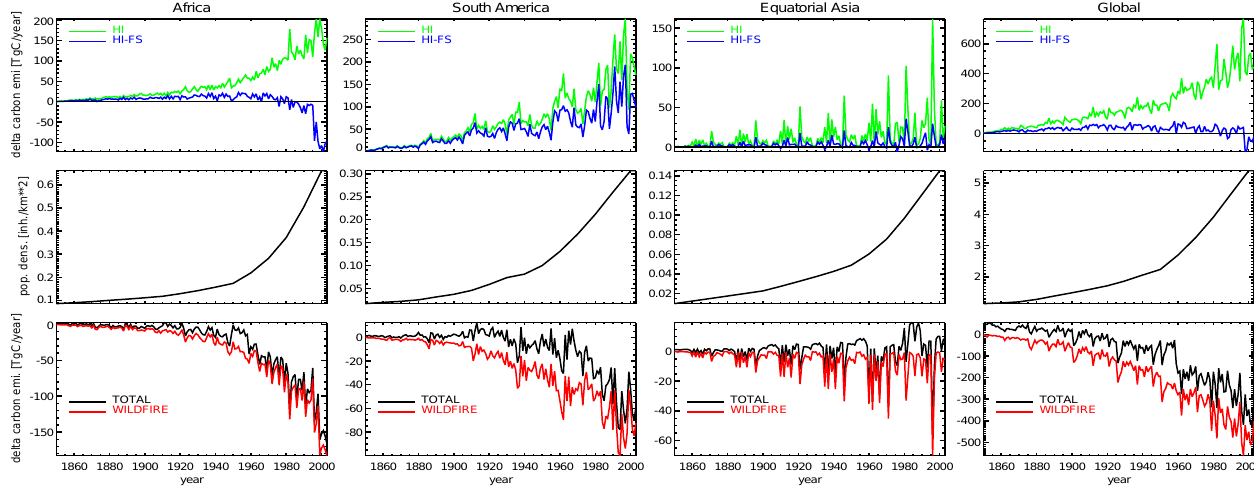
Fig. 8. Sensitivity to changes in population density and land use change and wood harvest for selected regions and globally. (A) Annual mean change in carbon emission from total fires (natural and deforestation) caused by changes in population density in the case of only human ignition is considered (green line, AB-HI – AB-HI-PI) and human ignition and fire suppression considered (blue line, AB-HI-FS – AB-HI-FS-PI) in [TgC/year]; (B) population density [inhabitants/km 2 ]; (C) change in total (wildfire and deforestation) fire carbon emissions (black) and wildfire fire carbon emissions (red) caused by land use change and wood harvest in [TgC/year] (AB-FULL –